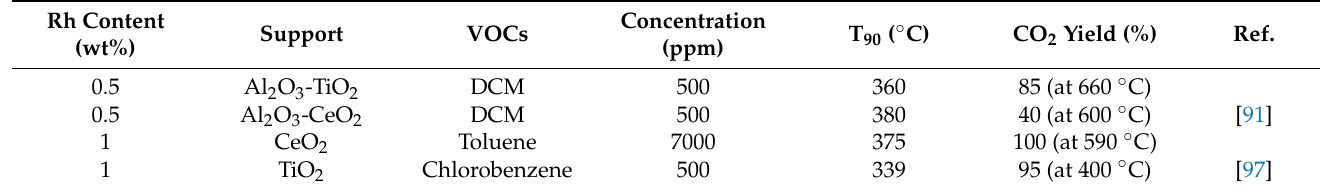
Table 6. Comparison of Rh-based catalysts on various supports for VOC